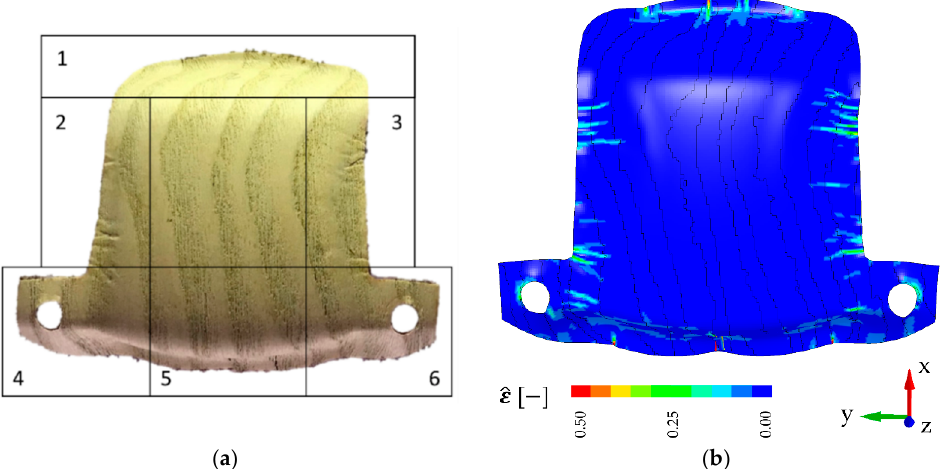
Figure 10. Forming results of sample 𝟐 ∥ . ( a ) Experiment; ( b ) simulation with output of equivalent strain.